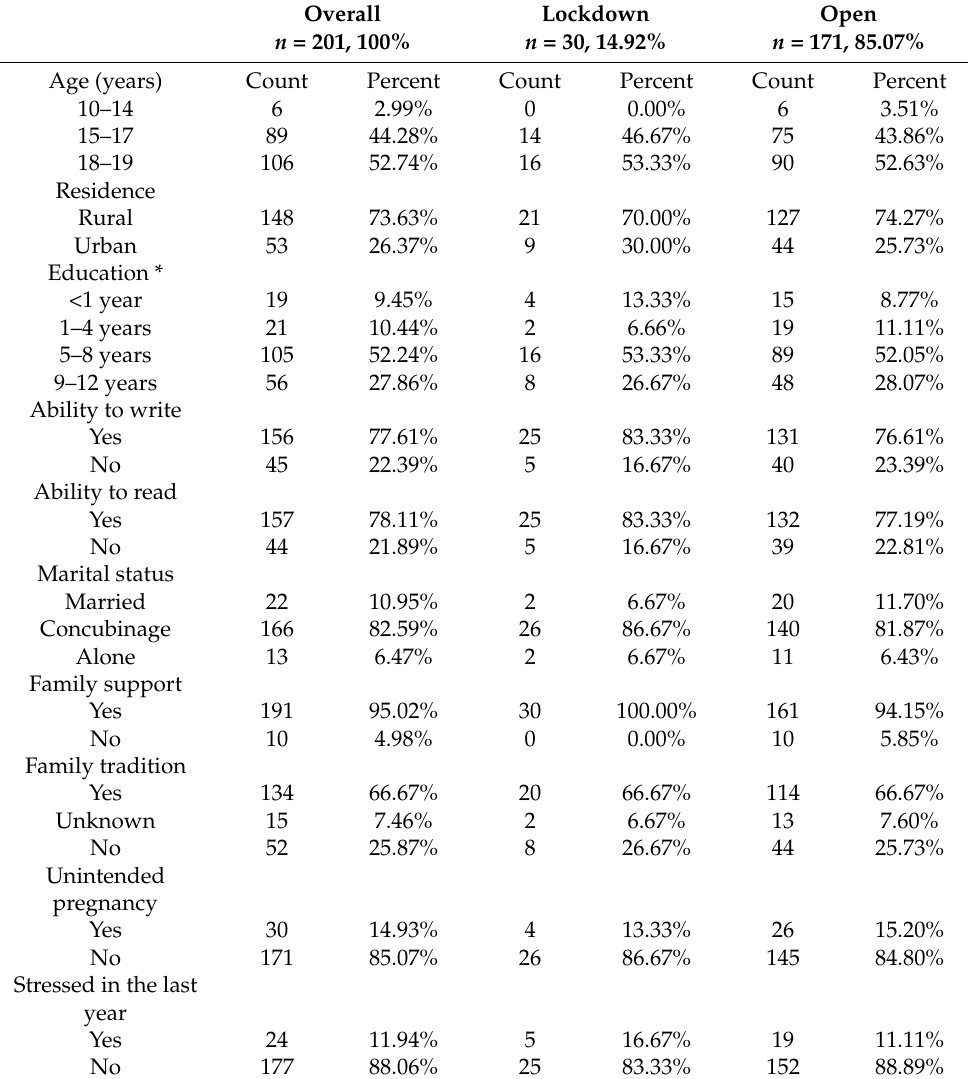
Table 1. Baseline characteristics of sample groups.